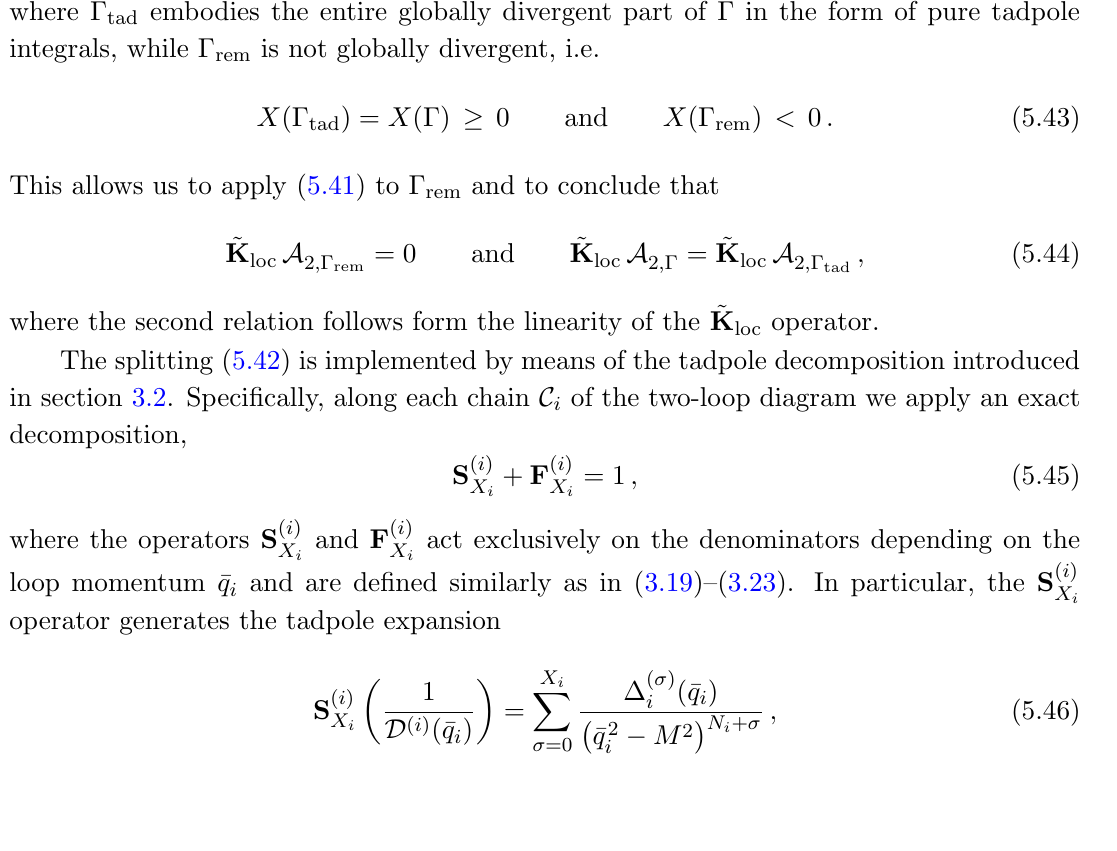
= (cid:14) = 2 ;(cid:13) R 2 ;(cid:13)